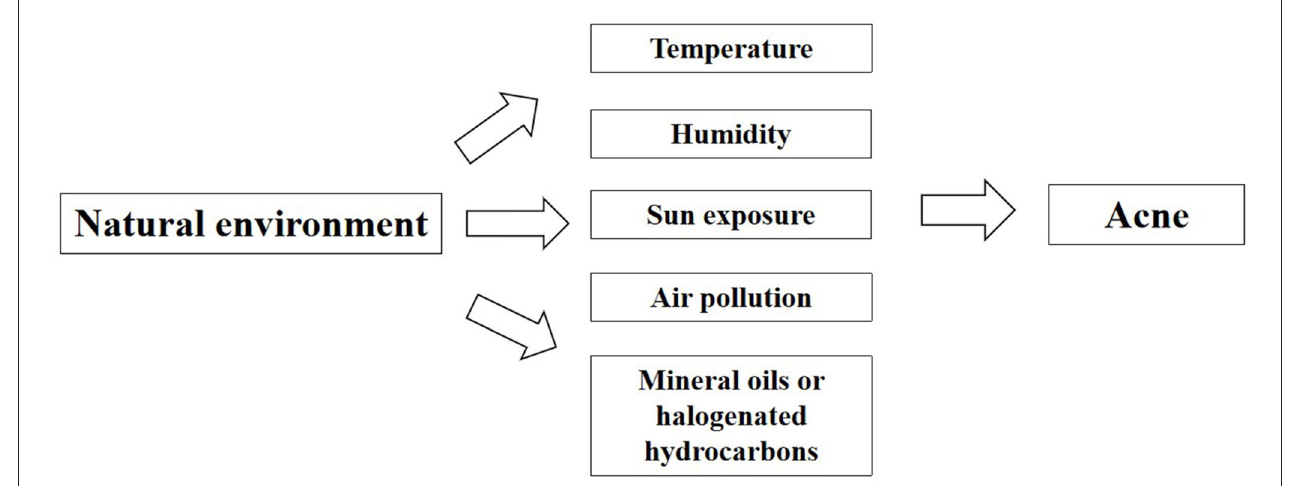
FIGURE 3 | Factors of natural environment affecting